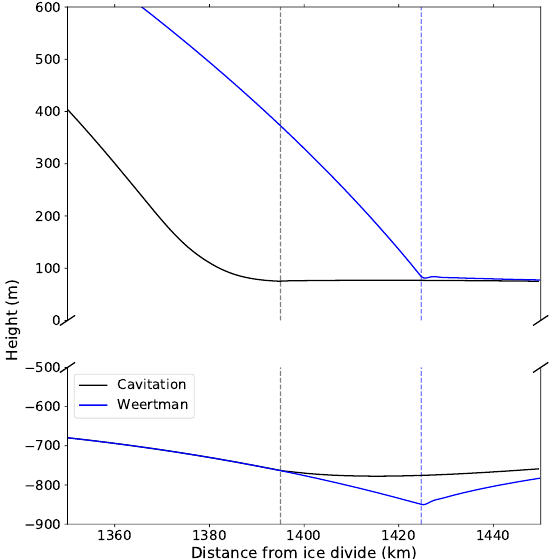
Figure 5. Detail of ice sheet profiles at t = 0 for both cavitation sliding and Weertman sliding. Dashed vertical lines indicate the po- sition of the grounding